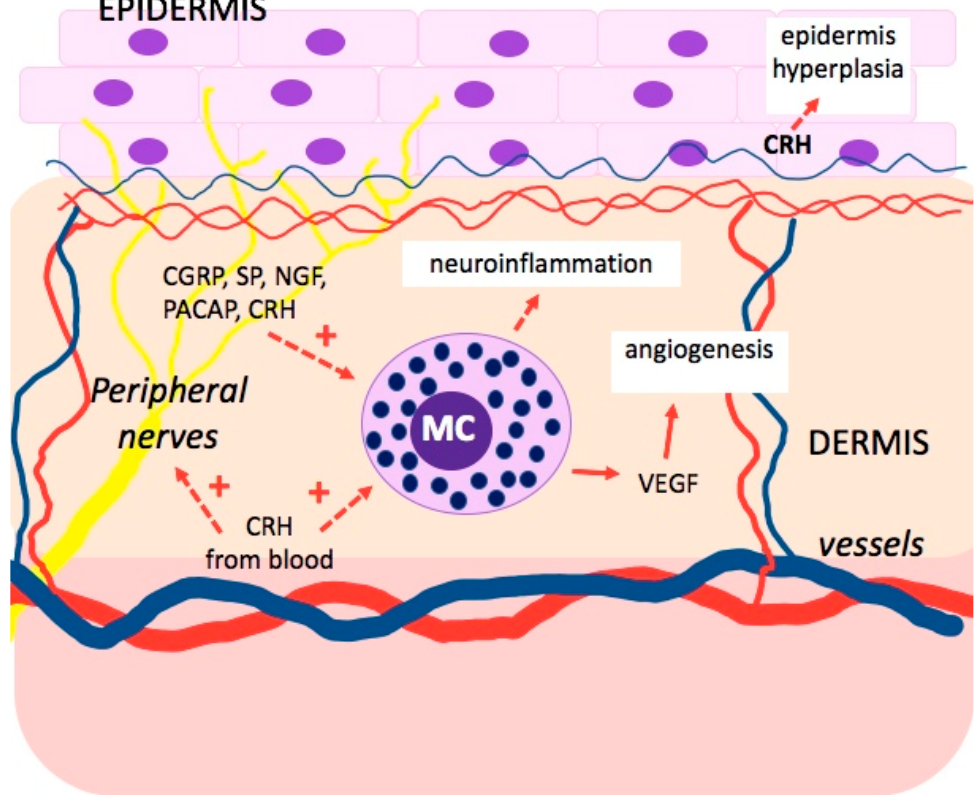
Figure 2. The influence of psychological stress on the activation of mast cells and the development of neuroinflammation in psoriasis. Vascular endothelial growth factor (VEGF), corticotrophin-releasing hormone (CRH), substance P (SP), pituitary adenylate cyclase-activating polypeptide (PACAP), nerve growth factor